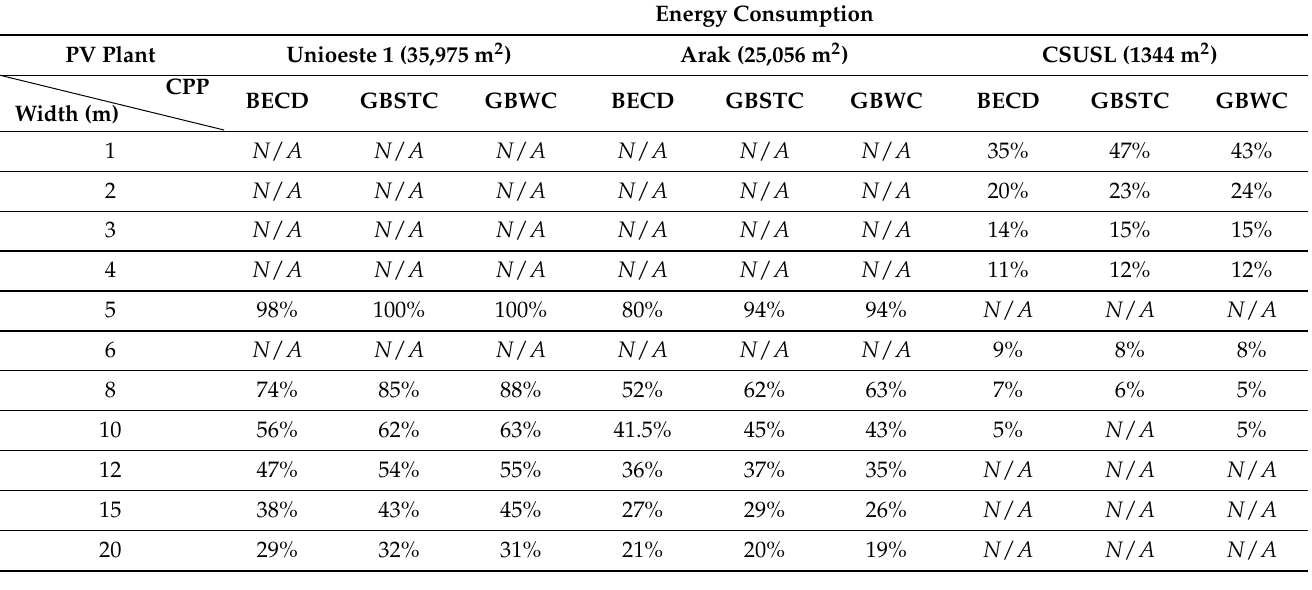
Table 1. Comparison of three CPP methods with regard to CPP width, for a simulated Typhoon UAV at three PV plants.